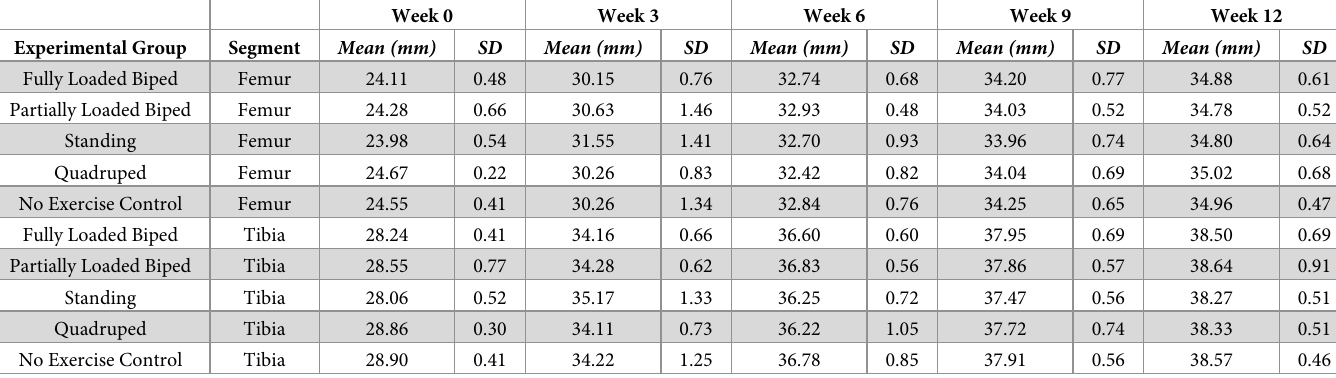
Table 3. Mean femur and tibia lengths by